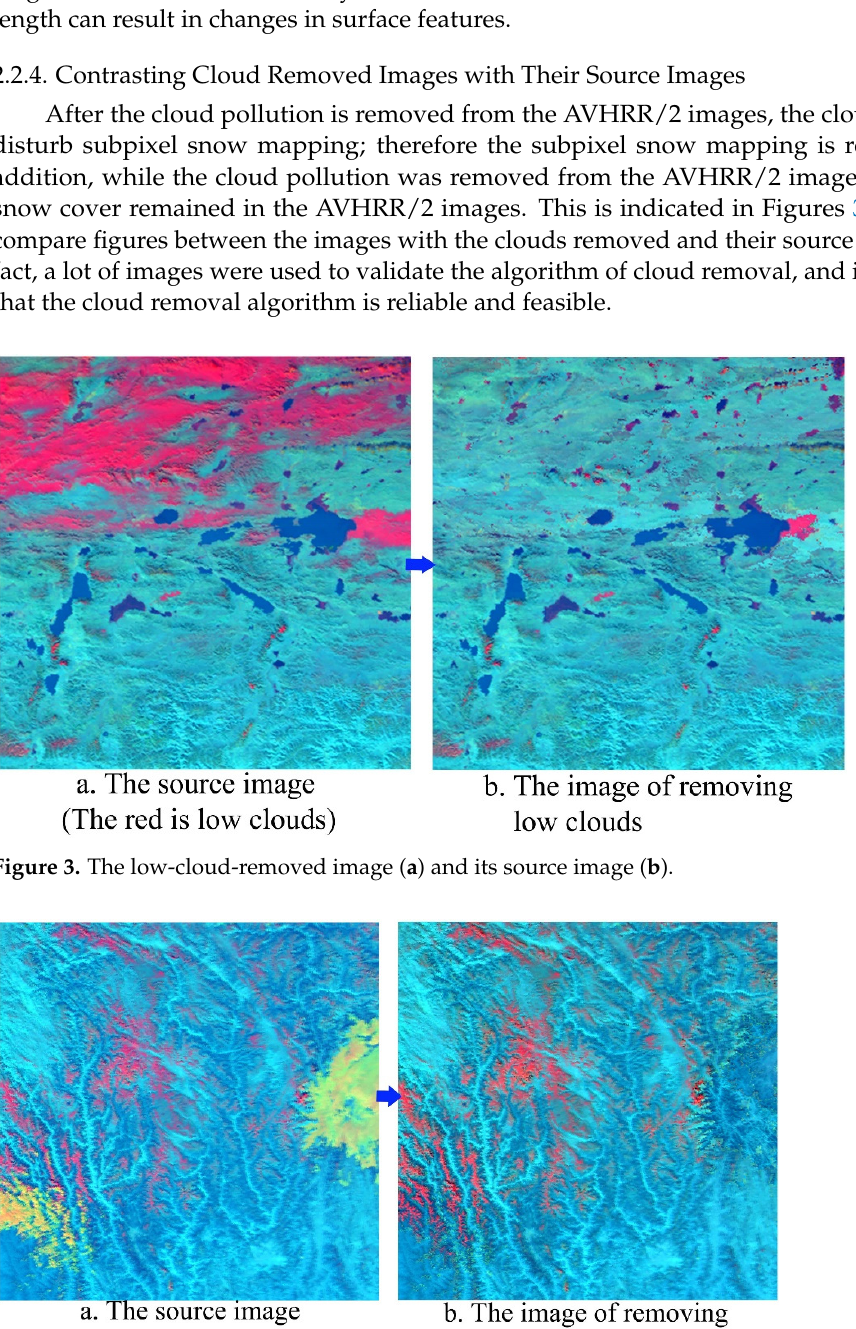
Figure 5. The high-cloud-removed image ( a ) and its source image ( b ).